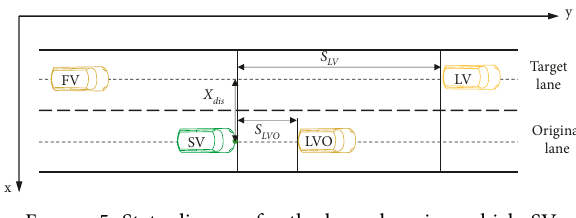
Figure 5: State diagram for the lane-changing vehicle SV.